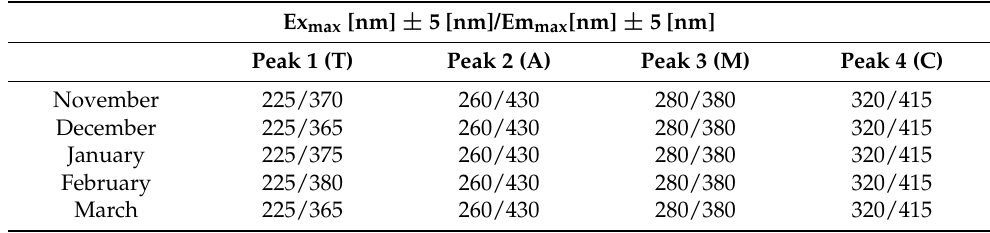
Table 5. Major fluorescent peaks of natural seawater with their wavelength-independent fluorescence maxima ( λ Ex / λ Em ) for particular months in the period of November to